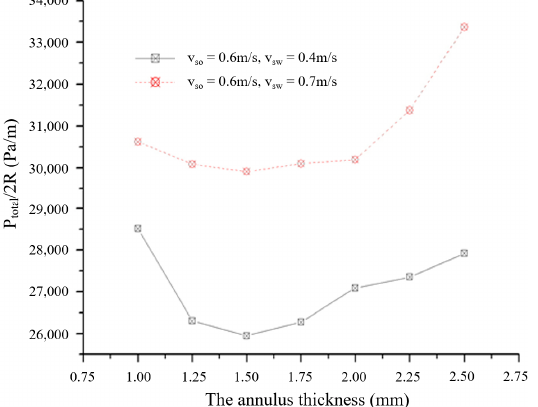
Figure 5. Relationship between annular layer thickness and pressure drop [34]. ( v so and v sw are the superficial velocities of water and oil, respectively.)